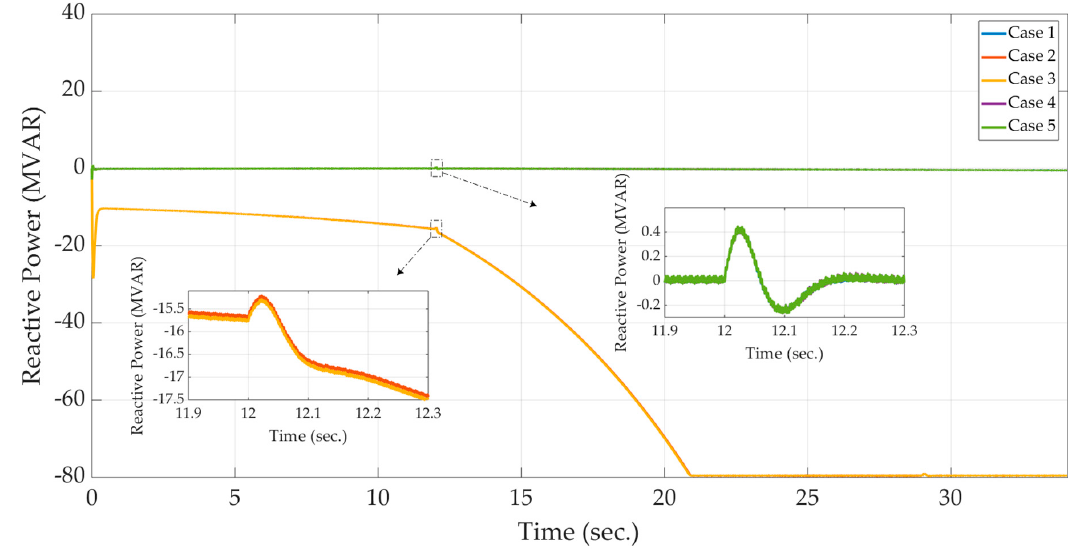
Figure 22. The impact of modifications of droop settings on the reactive power profile of VSC-HVDC station #4 in the third scenario.